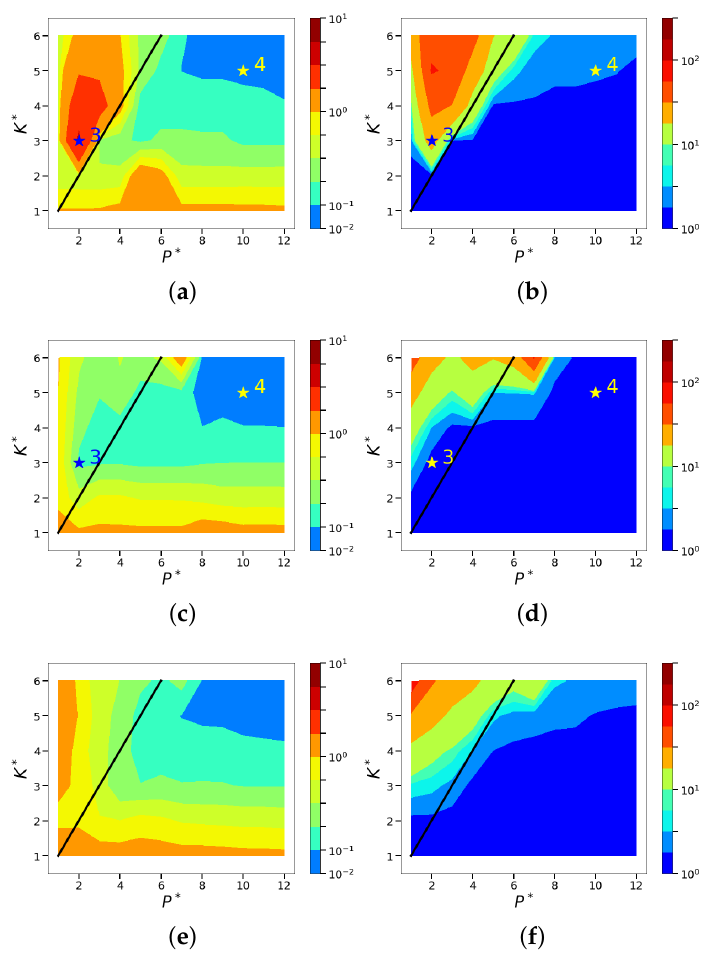
Figure 11. Isocontours of the normalized mean squared POD-based sparse reconstruction errors ( l 2 norm) corresponding to the sensor placement with maximum and minimum errors from the chosen ensemble of random sensor arrangements. The average error across the entire ensemble of ten random sensor placements is also shown. Left: normalized absolute error metric, (cid:101) 1 . Right: normalized relative error metric, (cid:101) 2 . ( a ) (cid:101) 1 (maximum); ( b ) (cid:101) 2 (maximum); ( c ) (cid:101) 1 (minimum); ( d ) (cid:101) 2 (minimum); ( e ) (cid:101) 1 (average); and ( f ) (cid:101) 2